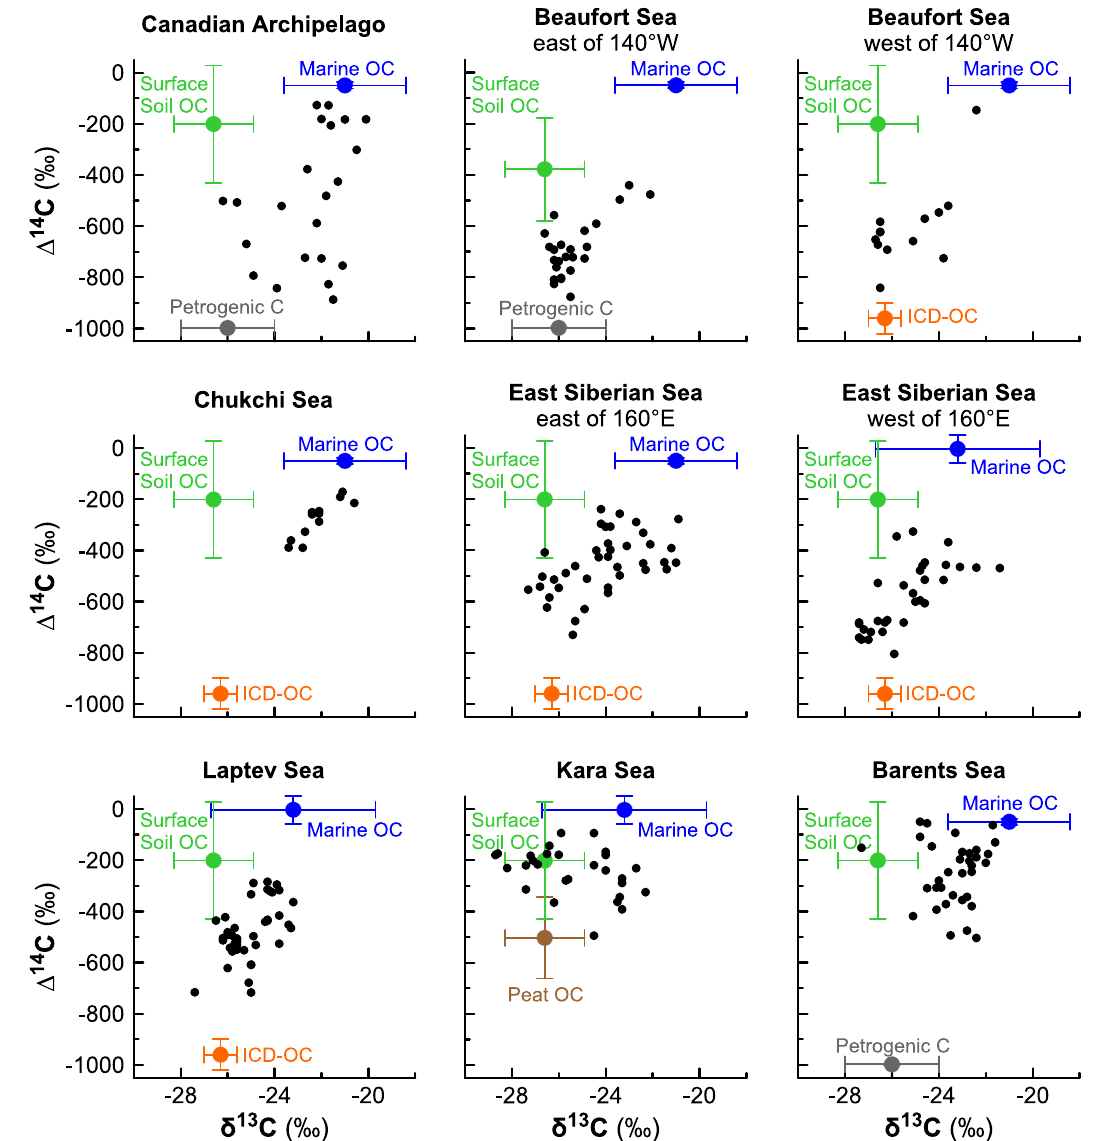
Fig.2|Scatterplotsof δ 13 C- Δ 14 CpatternsofOCincircum-Arcticshelfsediments based on the Circum-Arctic Sediment Carbon Database - CASCADE 20,21 . Shown aredataforsurfacesedimentsamples,aswellasthemeanandstandarddeviations of the different end members shown as colored points and error bars (in green SurfaceSoilOC,inorangeIceComplexDeposit – ICD-OC,inbrownPeatOC,inblue